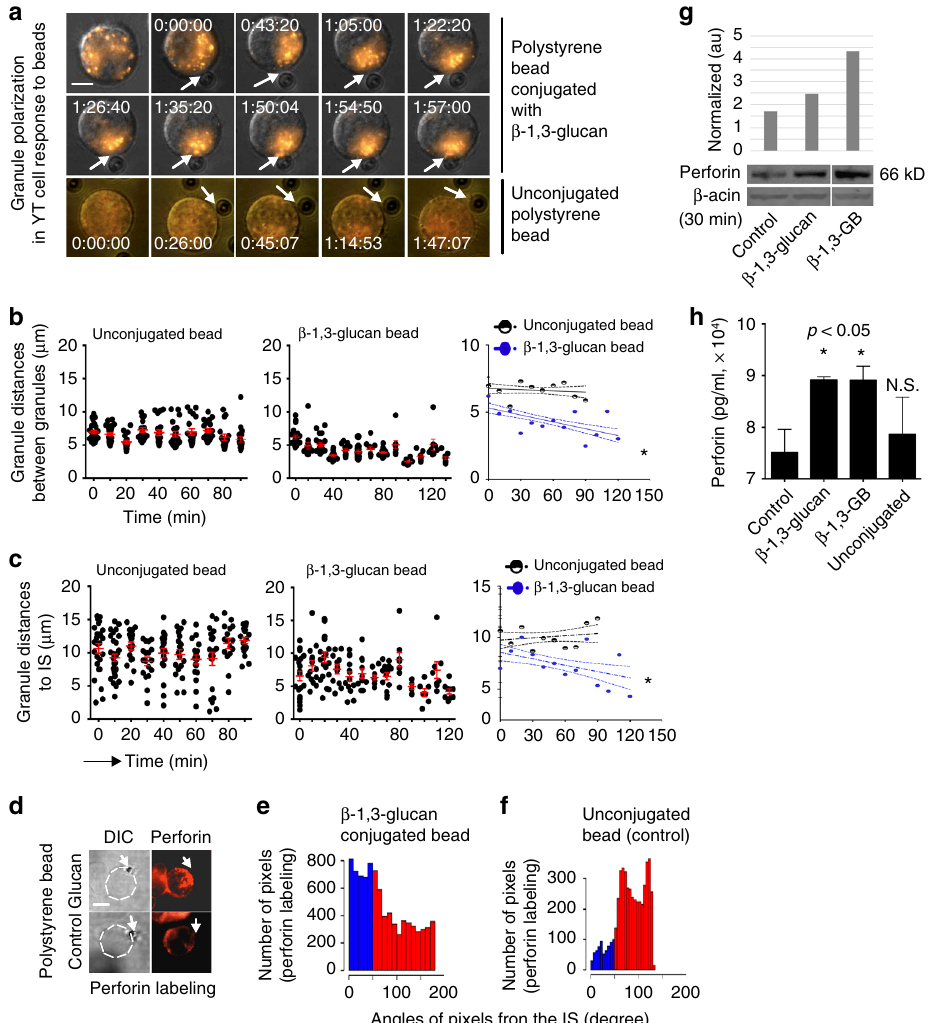
Fig. 4 β -1,3-glucan stimulates granule polarization in NK cells. a Representative images from real-time live cell imaging (Supplementary movie 1) of granule polarization toward the IS in NK cells in response to β -1,3-GB. YT cells were loaded with Lysotracker Red to visualize granules and mixed with β -1,3-glucan- conjugated, or control beads . The experiment was repeated nine times with eight having similar results. Bar = 5 µ m. b Distance between granules (black circles) and mean distance between granules (red symbols) from panel a . The mean distance between granules with 95% con fi dence intervals is shown in the right panel. c Distances between granules and the IS, de fi ned as the center of the point of contact between a YT cell responding to unconjugated beads (left panel) or β -1,3-glucan beads (middle panel) from panel a . The mean distance from granules to IS with 95% con fi dence intervals is shown in the right panel. Distances were determined at times throughout the video and do not necessarily corresponding to times in a . d Perforin expression and polarization at the IS between YT cells and β -1,3-GB in a representative single YT cell (20 cells analyzed). Experiments were repeated at least three times with similar results. Bar = 5 µ m. e Proximity of perforin labeling to the radius de fi ned by the center of the IS with the β -1,3-GB. Polarization was de fi ned when the peak of fl uorescence was at an angle < 45° (blue bars in the left). f Proximity of perforin labeling to the synaptic radius with unconjugated bead. Polarization was de fi ned when the peak of fl uorescence was at an angle < 45° (blue bars in the left). g Western blot analysis of perforin expression in YT cells in response to soluble and β -1,3-GB. The experiment was repeated at least three times with similar results. h Perforin levels released in the culture media assessed using ELISA. YT cells were treated with soluble β -1,3-glucan, β -1,3-GB, or control. Quadruplicate determinations were performed in two experiments with similar results. N.S. non-signi fi cant. *, p < 0.05. Data were analyzed using one-way ANOVA ( b , c , h